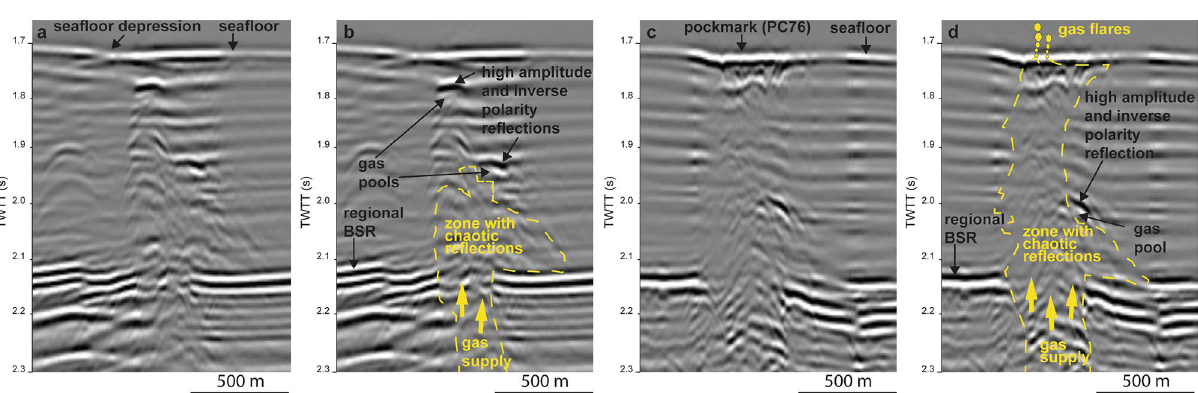
Figure 5. Uninterpreted ( a , c ) and respective interpreted ( b , d ) sectors of seismic profile in Fig. 3e showing a zone of low amplitude and chaotic reflections between the regional bottom simulating reflector (BSR) and the seafloor. Note the presence of reflections of high amplitude and reverse polarity reflections (in relation to the seafloor), which indicate the top of possible gas pools within the GHSZ (i.e., methane trapped as free gas in the hydrate structure and/or coexisting with gas hydrate and “dry” sediments, or both). Free gas is supplied from depth to the GHSZ across the amplitude loss interval or gap in the regional BSR. Gas flares were detected in the pockmark showed in ( c ) and ( d ), which has also been cored to recover gas hydrate 38 (PC76; see Fig. 4a for